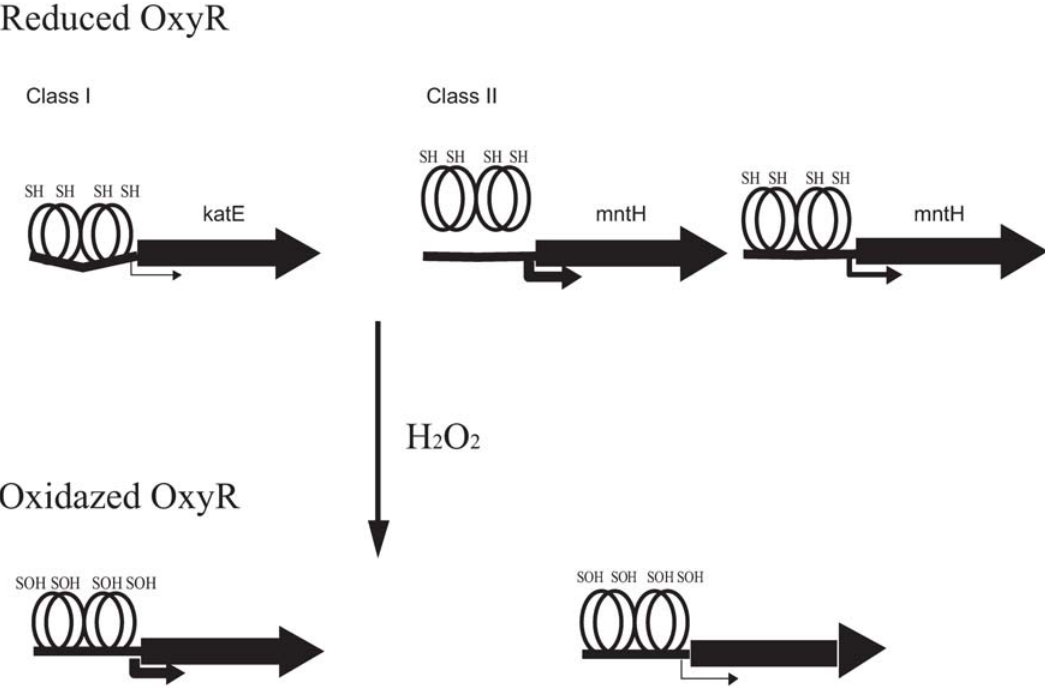
Figure 7. Model for reduced and oxidized OxyR binding to and activation at the two classes genes. For Class I ( katE ): OxyR activates gene in the presence of H 2 O 2 , whereas under non-stressed conditions, reduced OxyR is bound to two pairs of adjacent major grooves separated by one helical turn of the DNA duplex and acts to repress its own synthesis. For Class II ( mntH ): mutation of OxyR can greatly enhance gene expression, reduced OxyR binds to DNA and minimally induced genes, whereas oxidized OxyR significantly decreases the gene expression